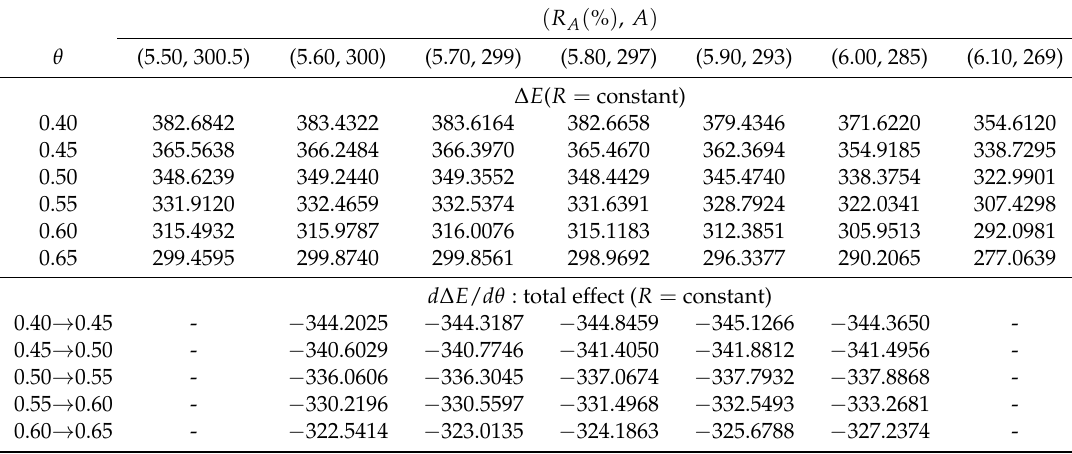
Table 6. Responsiveness of efficiency gain from CEO overconfidence to buying distressed assets when asset-side interest margin is considered, Equation (20) 1